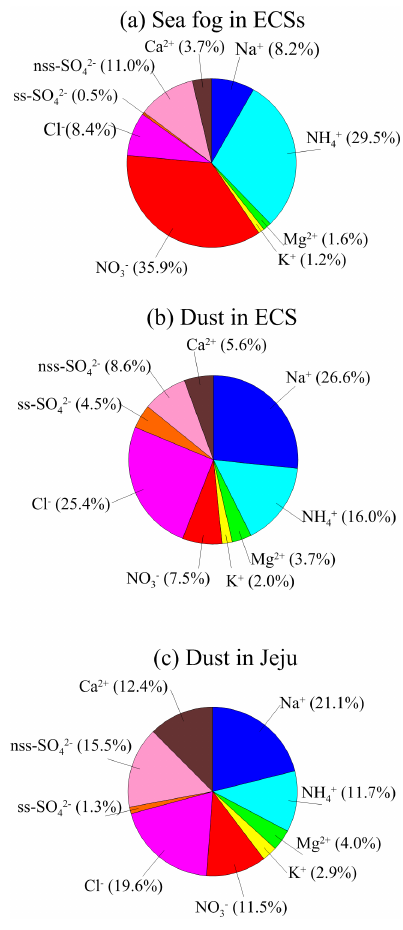
Figure 7. Pie charts of ion distribution for (a) sea-fog-modified aerosols (this study), (b) dust aerosols collected over the East China Sea ( n = 8) (Hsu et al., 2010b), and (c) dust aerosols collected on the island of Jeju ( n = 49) (Kang et al.,